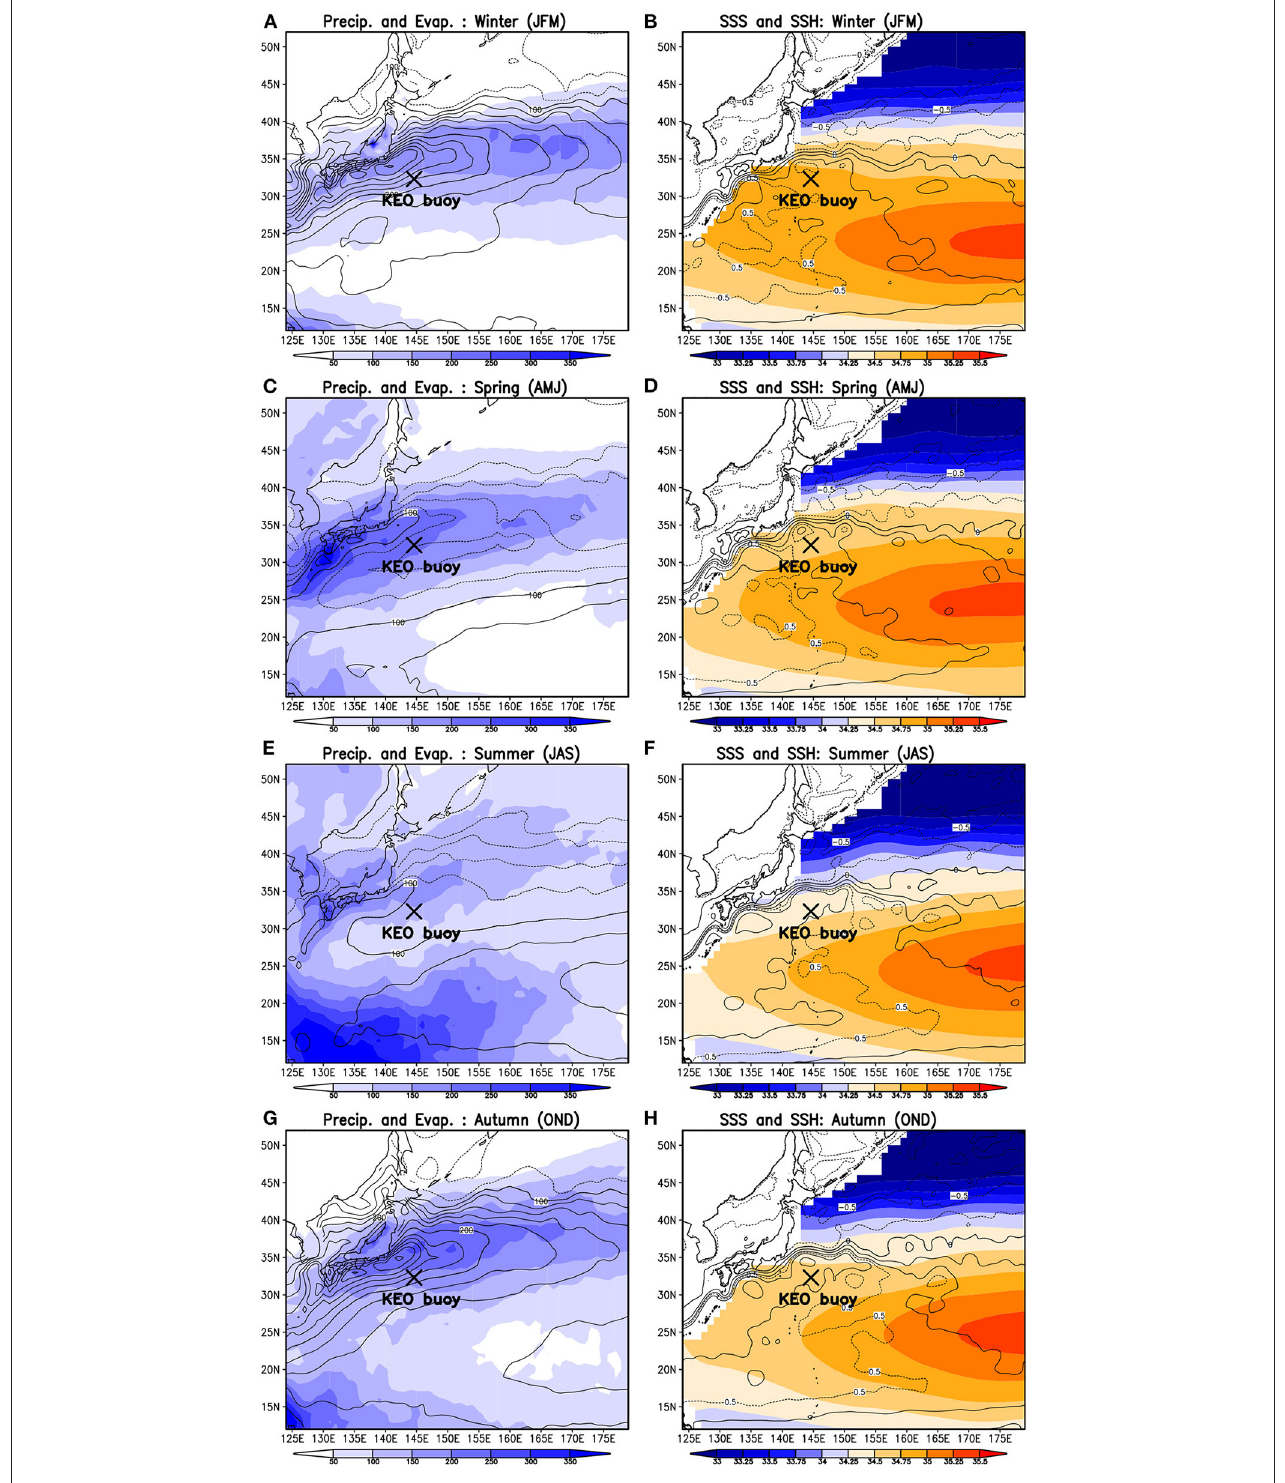
FIGURE 4 | Seasonal climatology of precipitation rate, evaporation rate, sea surface salinity, and sea surface height in the western North Pacific for 2003-2017. Left panels show precipitation rate from GSMaP (color shading with a unit of mm/month) and evaporation rate from Objectively Analyzed Air-Sea Fluxes (OA-flux) data (solid-contours for ranges greater than 150 mm/month and dashed contours for smaller ranges with an interval of 50 mm/month). Right panels show sea surface salinity from Argo data (color shading with a unit of PSU) and sea surface height from JCOPE2 reanalysis (solid- and dashed-contours for positive and negative values, respectively, with an interval of 4cm). (A,B) January-March, (C,D) April-June, (E,F) July-September, and (G,H) October-December. The location of the KEO buoy is marked at 32 ◦ N and 144 ◦ E.